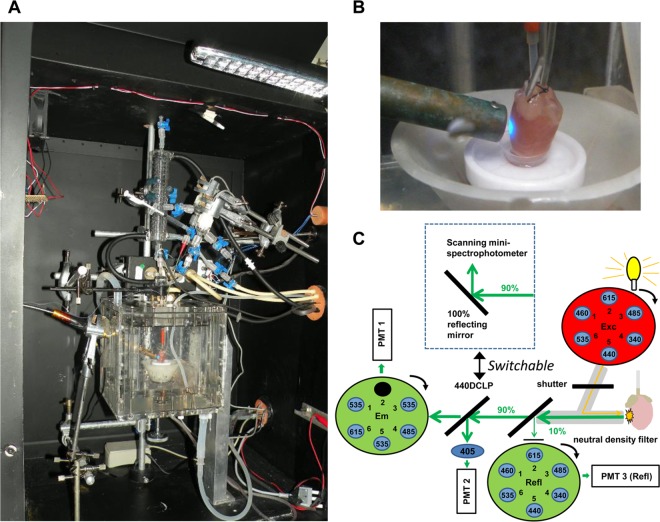
Design of the bespoke surface fluorescence apparatus.A, Picture of the interior of the light-proof box showing the water jacketed perfusion chamber containing a Langendorff-perfused rat heart. B, Zoom in of the perfusion chamber to show that the light is shining on the surface of the left ventricular free wall and that motion artefact was minimized by placing hearts’ apex in a small retaining cup. C, Schematic of the optics. Insert shows alternative configuration for measuring surface fluorescence spectra by switching between the 440 DCLP dichroic mirror for filter based measurements and a 100% reflecting mirror for fluorescence spectrum measurements.